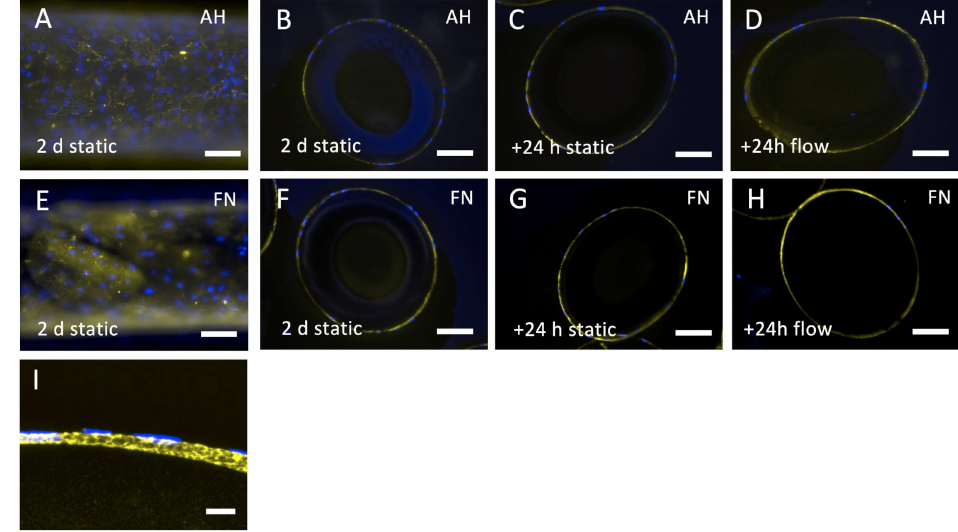
Figure 9. Collagen Type-IV detection on endothelialized and flow exposed HFM. Endothelialized AH ( A – D , I ) or FN ( E – H ) coated HFM were analyzed for collagen-type IV expression (yellow). Top view of endothelialized AH ( A ) and FN ( E ) coated HFM after 2 days under static cultivation. Ultrathin cross-sections of endothelialized AH ( B ) and FN ( F ) coated HFM after 2 days under static cultivation, after another 24 h either under static ( C , G ), or flow conditions ( D , H ). Höchst33342 dye was used to counterstain cell nuclei ( blue ); Scale: 100 µ m. ( I ) Confocal laser scanning microscopy images were acquired to verify the basal-lamina-like location of collagen-type IV on the HFM surface; Scale: 10 µ